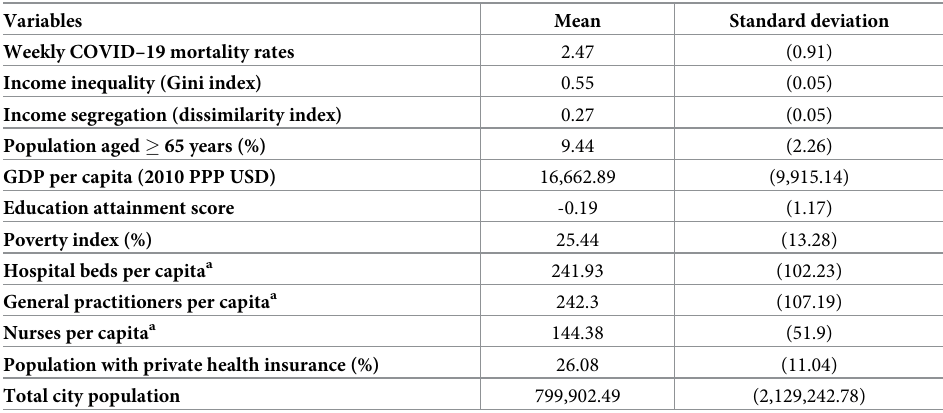
a Per capita indicators were multiplied by 100,000 prior to computing the summary statistics in this table. Income inequality, income-based segregation, GDP per capita, poverty index and the educational attainment score are computed using data from the IBGE 2010 census. Data on healthcare (number of hospital beds, number of general practitioners, population with private health insurance) and demographics (population aged � 65 years old) are from 2019.